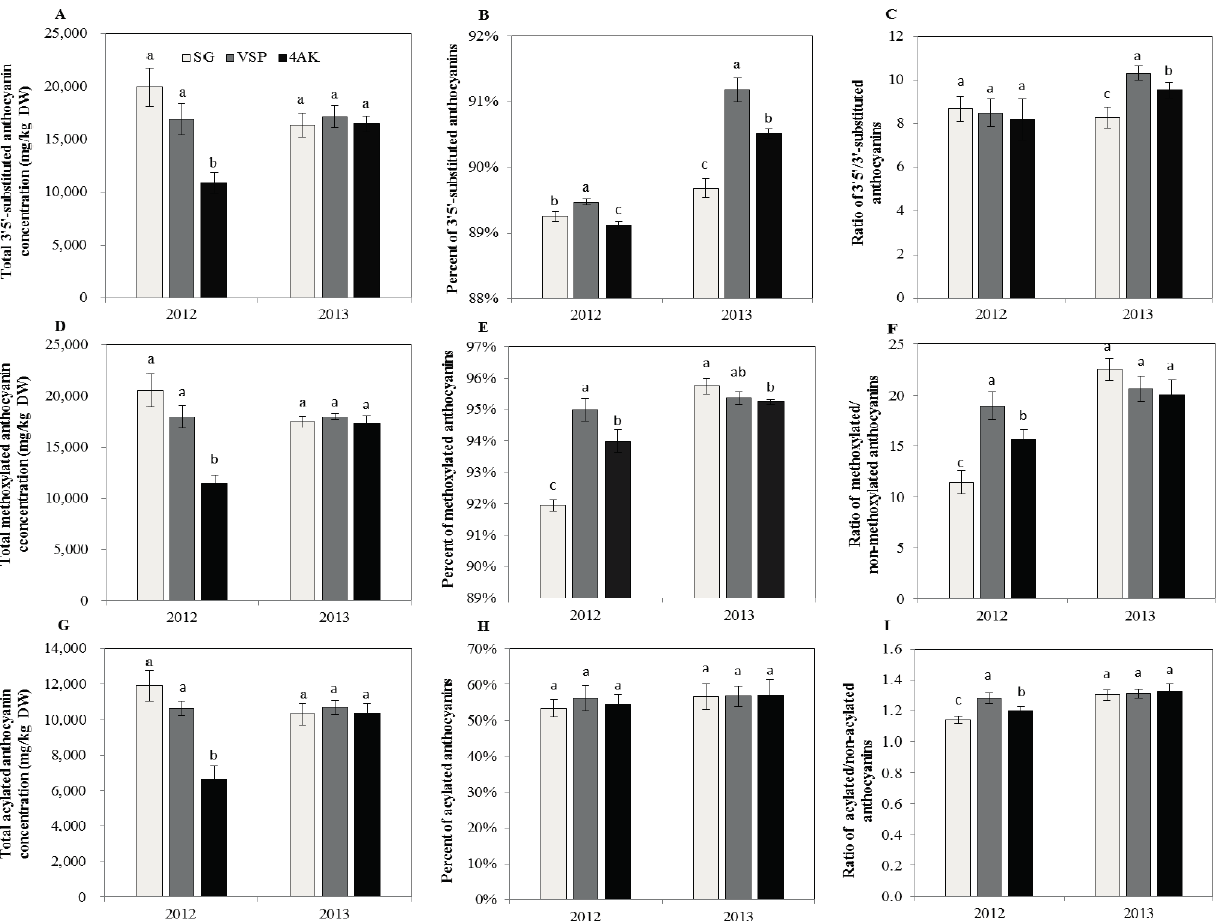
Figure 4. The concentrations and ratios of various anthocyanins in grape berry skins for the three training systems in 2012 and 2013. ( A ) The concentration of 3 ′ 5 ′ -substituted anthocyanins; ( B ) The percent of 3 ′ 5 ′ -substituted anthocyanins; ( C ) The ratio of 3 ′ 5 ′ /3 ′ -substituted anthocyanins; ( D ) The concentration of methoxylated anthocyanins; ( E ) The percent of methoxylated anthocyanins; ( F ) The ratio of methoxylated/ non-methoxylated anthocyanins; ( G ) The concentration of acylated anthocyanins; ( H ) The percent of acylated anthocyanins; ( I ) The ratio of acylated/non-acylated anthocyanins. DW, dry